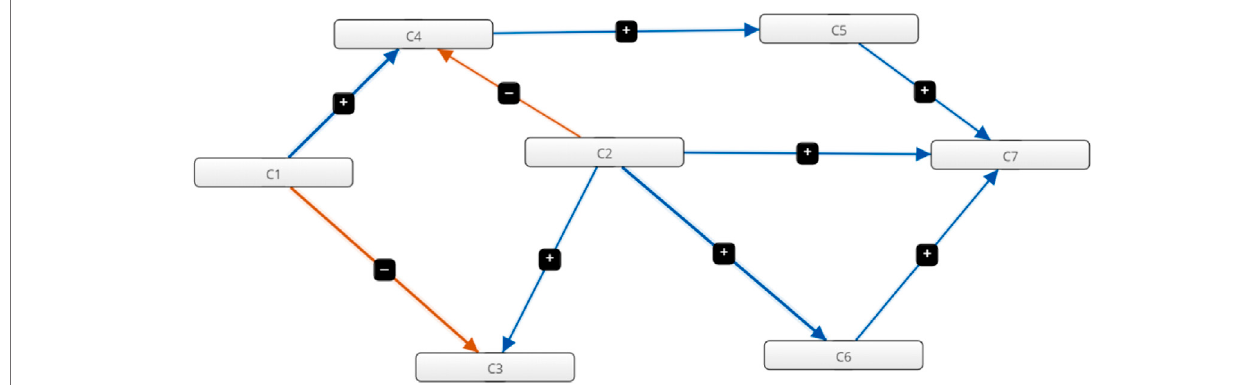
FIGURE 3 | A typical FCM graph depicting positive and negative causalities between